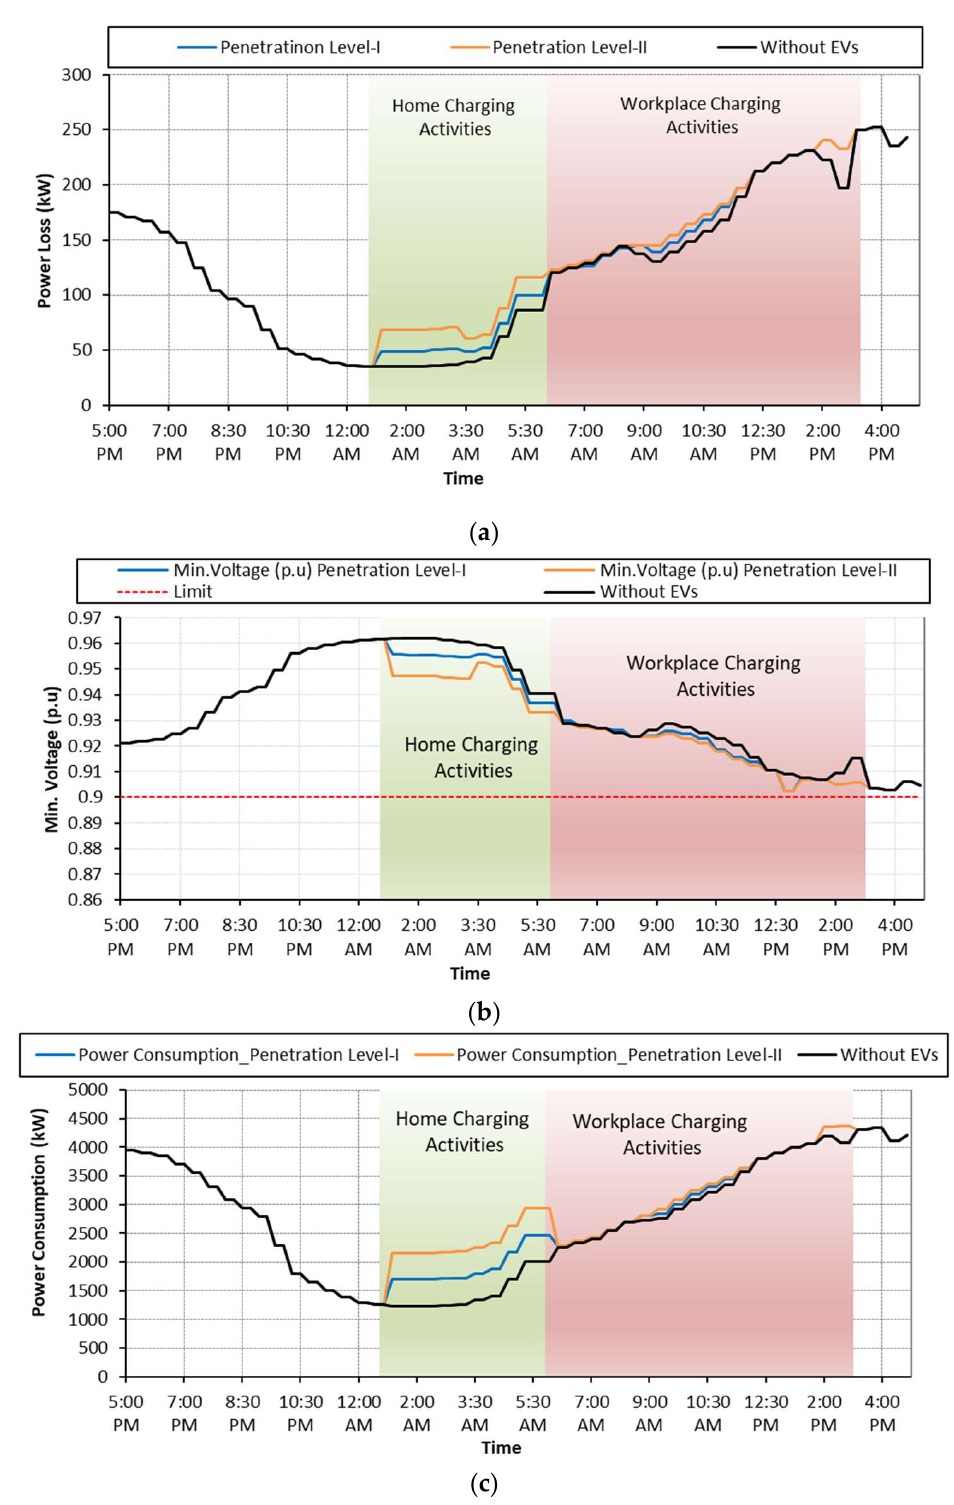
Figure 12. Case C ( a ) Network power loss; ( b ) voltage deviation; ( c ) network power consumption .